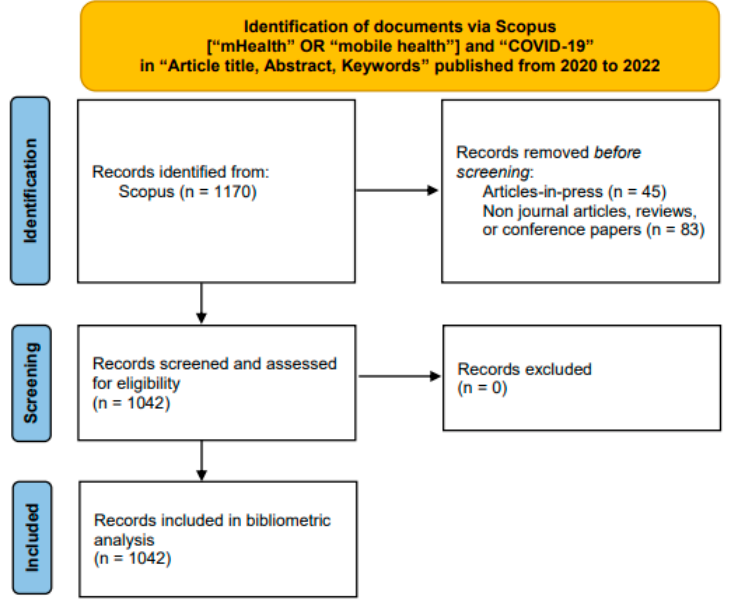
Figure 1. The flow diagram of the study (adapted from PRISMA 2020 Figure 1. The fl ow diagram of the study (adapted from PRISMA 2020 [21]).